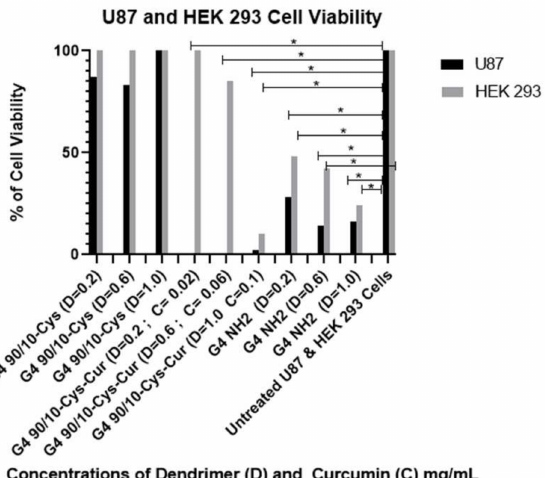
Figure 8. Viability of U87 and non-cancerous HEK 293 control cell after 24 h treatment with G4 90/10- Cys, G4 90/10-Cys-Cur, and G4 NH 2 . G4 90/10-Cys had no significant effect on reducing cell viability,